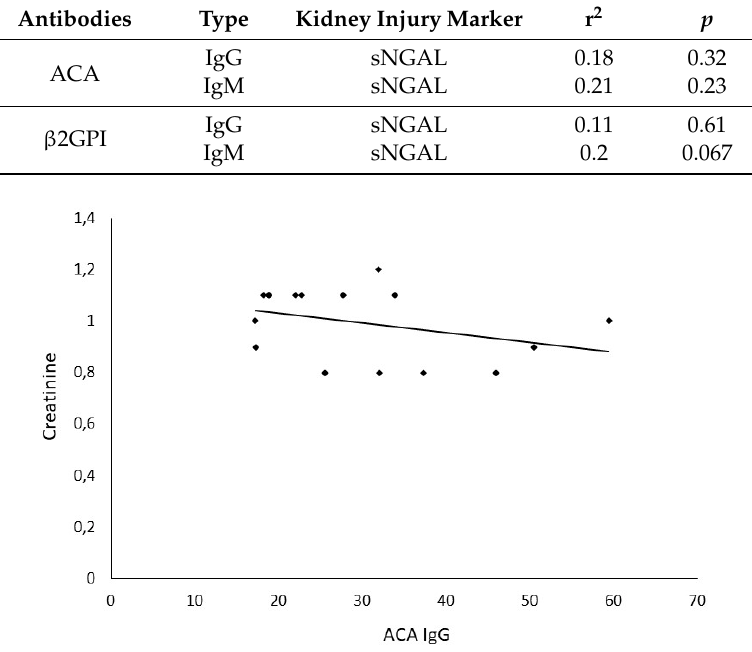
Figure 2. Correlation between creatinine and ACA antibodies. ACA IgG—anticardiolipin antibodies type G.